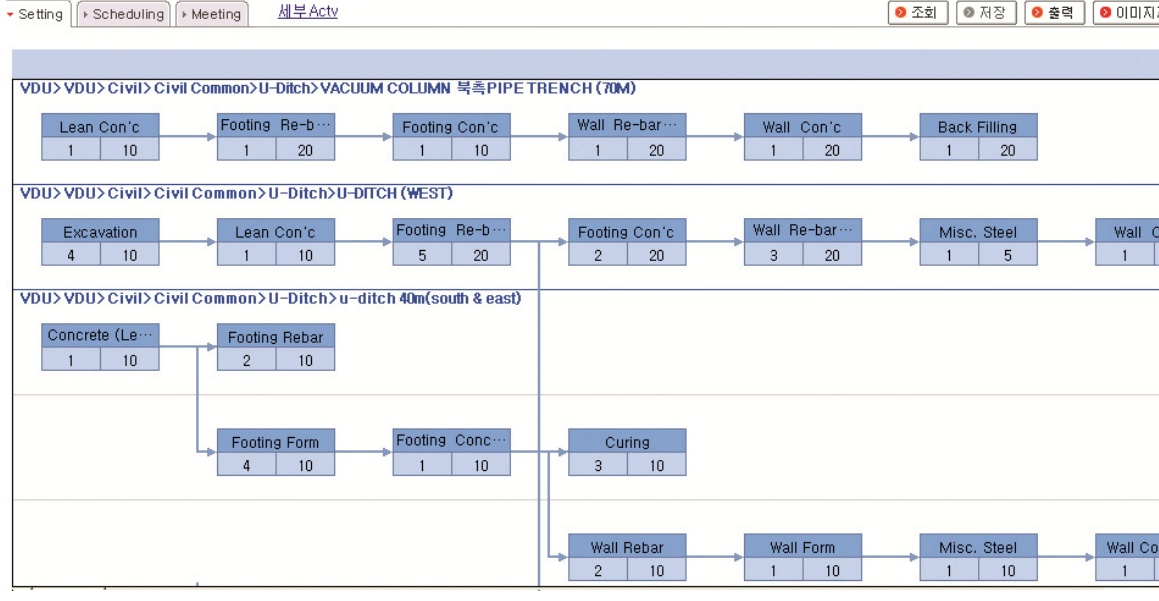
Fig. 4. Task setting